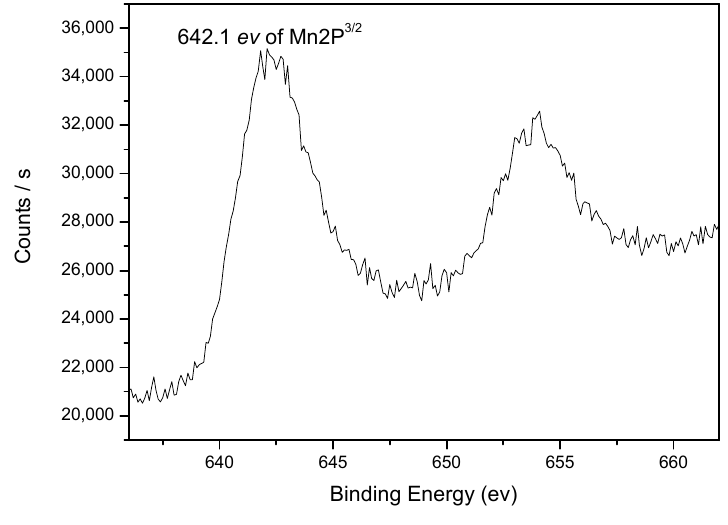
Figure 5. XPS spectra of catalyst 1.